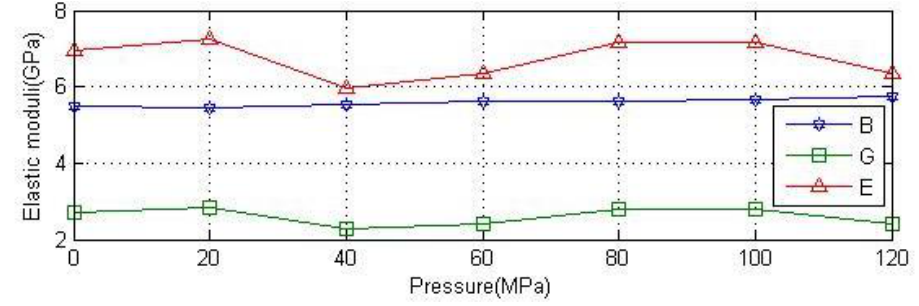
Figure 4. Variation of modulus of anhydrite crystal with pressure.